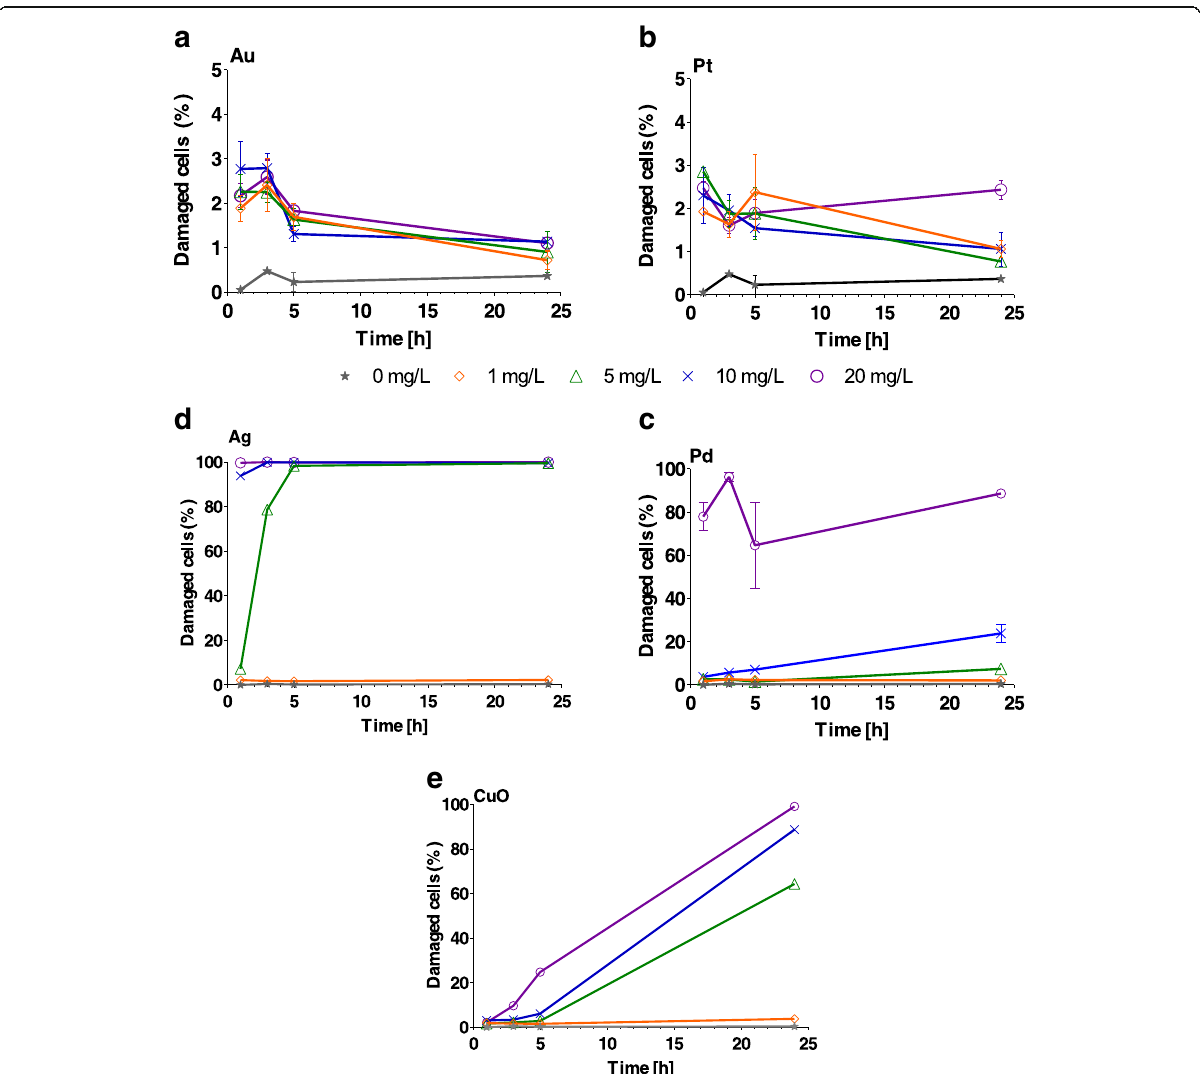
Fig. 4 Percentage of Chlamydomonas reinhardtii cells with damaged membranes following exposure to increasing concentrations (1, 5, 10 and 20 mg/L) of a Au, b Pt, c Pd, d Ag and e CuO nanoparticles after 1, 3, 5 and 24 h. The error bars represent the standard deviation of repeated experiments using duplicate samples. Note different y -axis scales for Au and